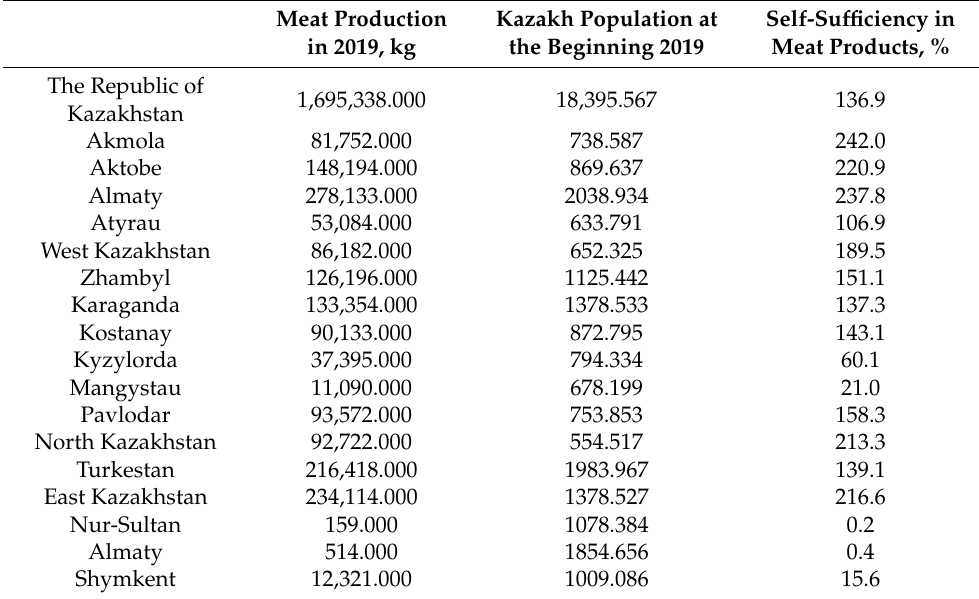
Table 4. Average self-sufficiency of the Republic of Kazakhstan in meat products (2019) (source: Stat.gov.kz, 2021. Available online: https://stat.gov.kz/ (accessed on 26 May 2021).